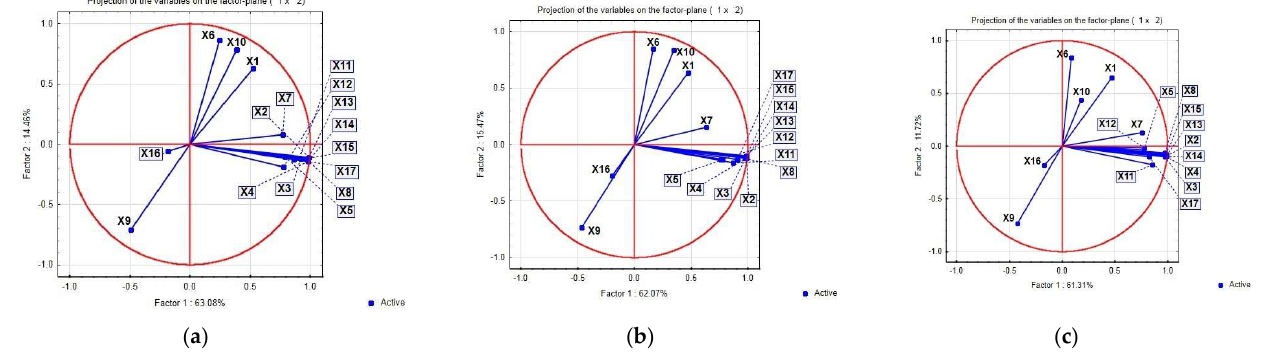
Figure 2. Variables of energy consumption factors in the two-dimensional space of the first and second components: ( a ) the distribution of factor loadings for 2010; ( b ) factor loadings for 2015; ( c ) factor loadings for 2019. Source: Own study based on the Statistica 13.3